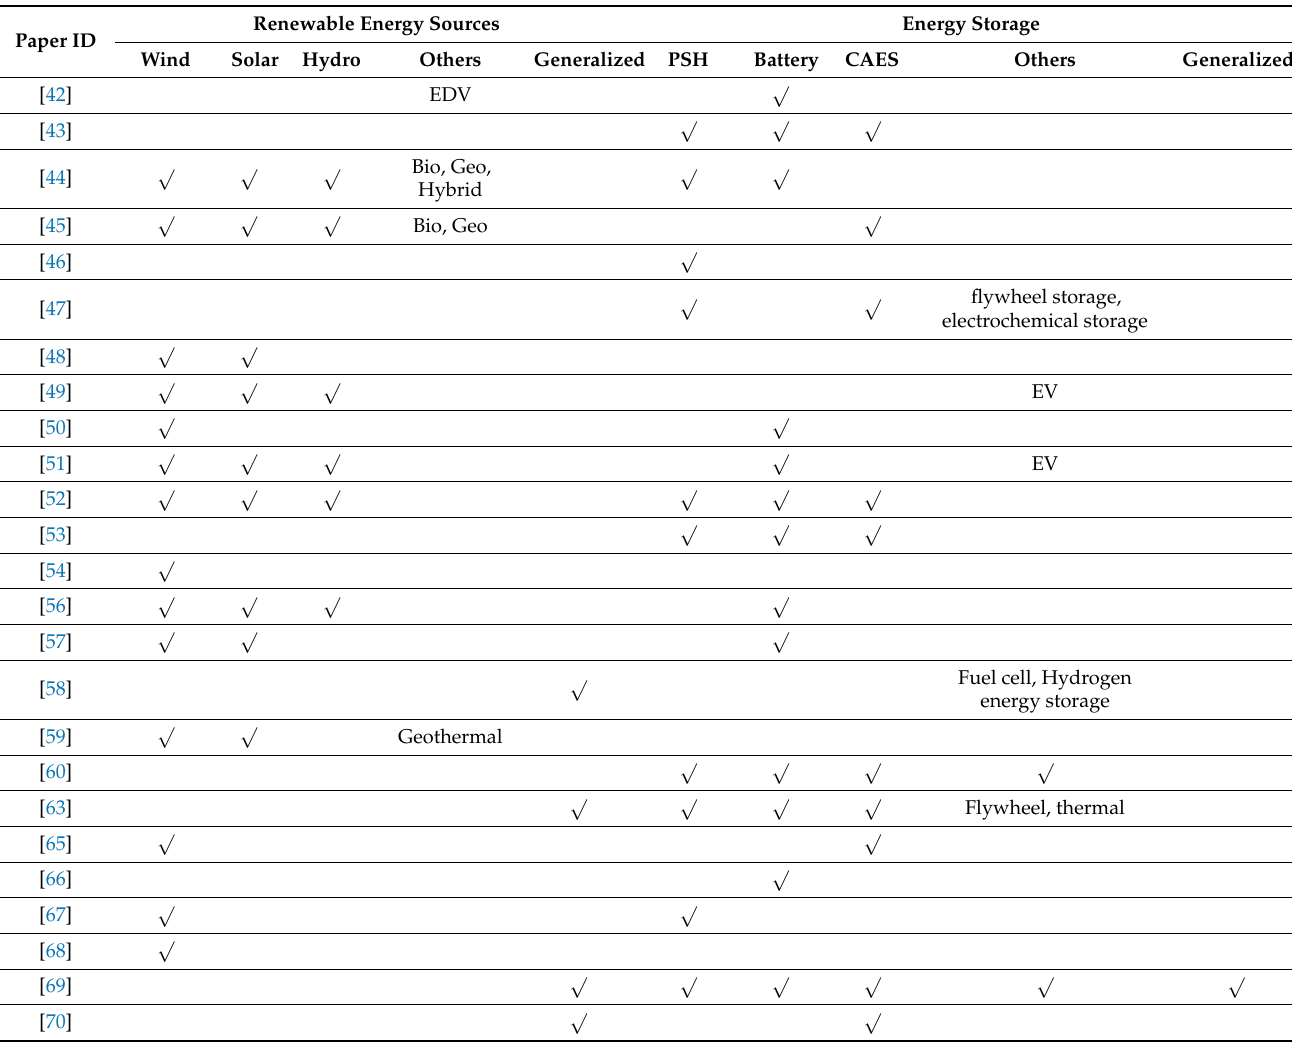
Table 2. Summary of reports for considered system details along with energy storage and renewable energy